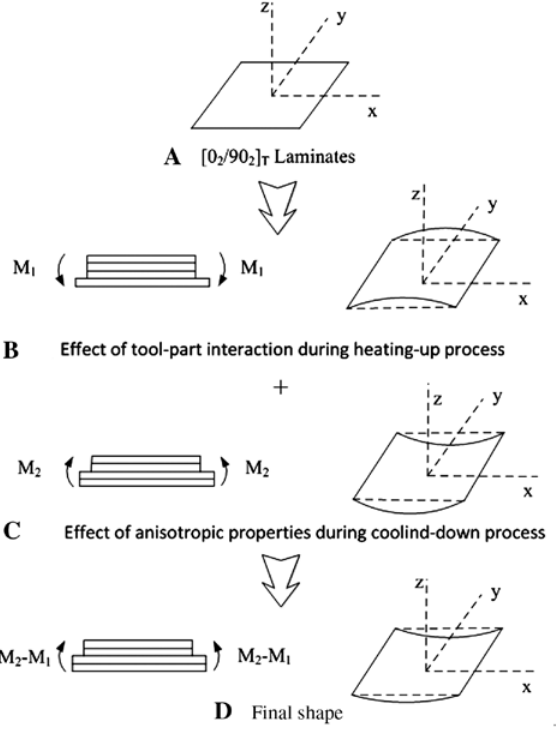
Figure 5: Effect of tool-part interaction during heating-up process for [0 /90 ] laminate. 2 2 T